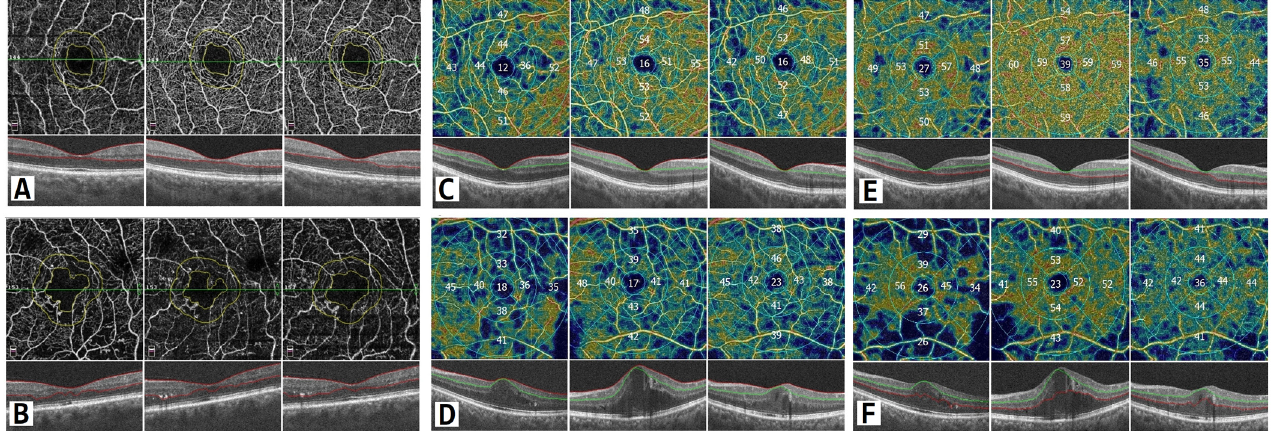
Figure 4. Vascular changes on OCT angiography. The scan area is 6 mm × 6 mm. Upper panel: patients without DME; lower panel: patients with DME. ( A , B ) FAZ changes showing distorted circularity among DME patients. ( C , D ) Vascular density changes in the superficial capillary plexus in parafoveal and perifoveal regions. ( E , F ) Vascular density changes in the deep capillary plexus in parafoveal and perifoveal regions during the three-month period. In color-coded maps warmer colors represent higher vascular density and numbers show vascular density in percentage.